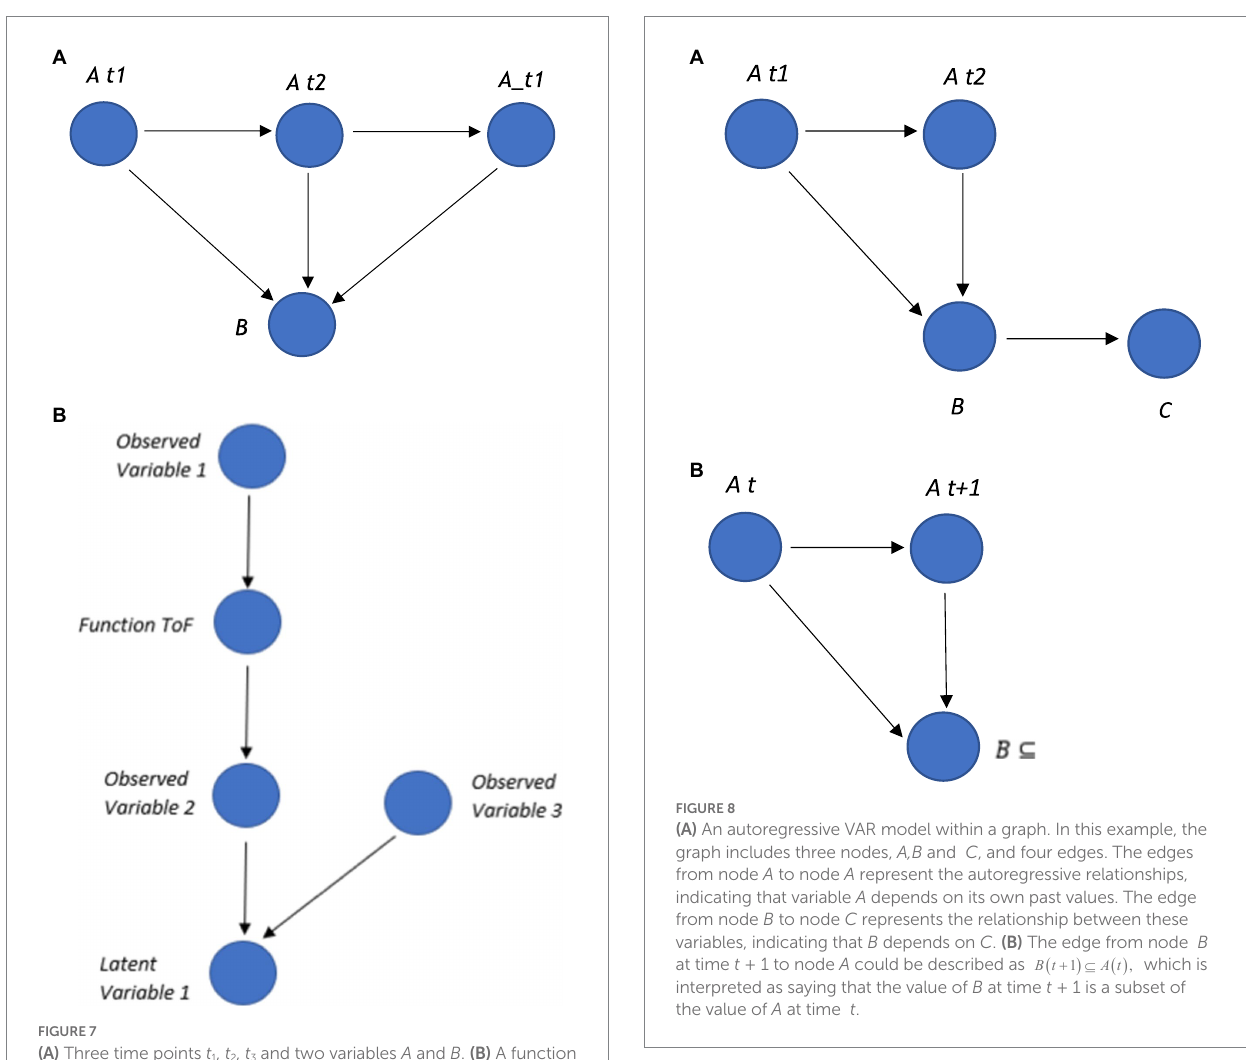
FIGURE 7 (A) Three time points t 1 , t 2 , t 3 and two variables A and B . (B) A function node between two observed variables that express some relations between these observed variables, such as latent variable=f(obsevered_variable_1,observed variable_2) .